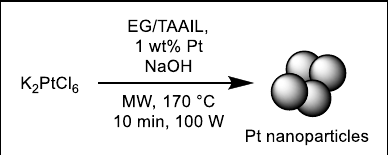
Figure 4. TEM images of (TAAIL)Pt-NPs obtained in the TAAILs [PhImPhC 4 ][NTf 2 ] (PP4), [Ph 2-Me ImPhC 5 ][NTf 2 ] (MPP4), [Ph 4-OMe ImPhC 4 ][NTf 2 ] (MOPP4) and [Ph 4-Br ImPhC 4 ][NTf 2 ] (BPP4).